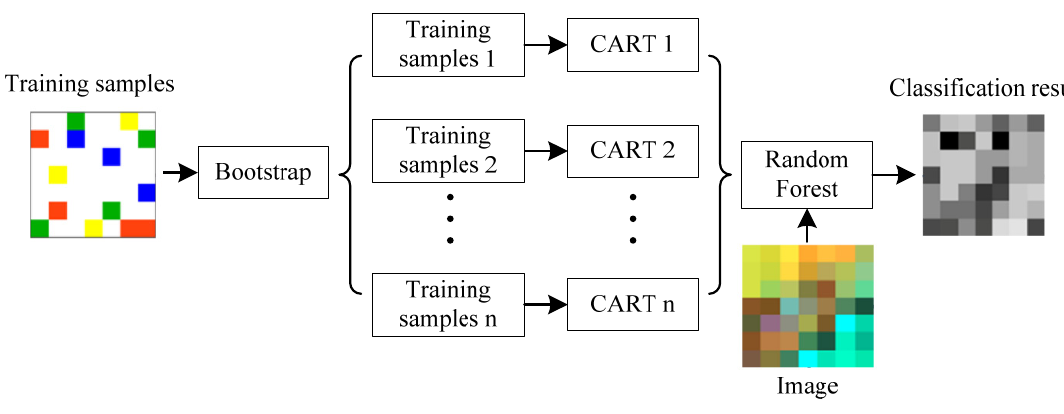
Figure 6. Schematic diagram of Random Forest for image